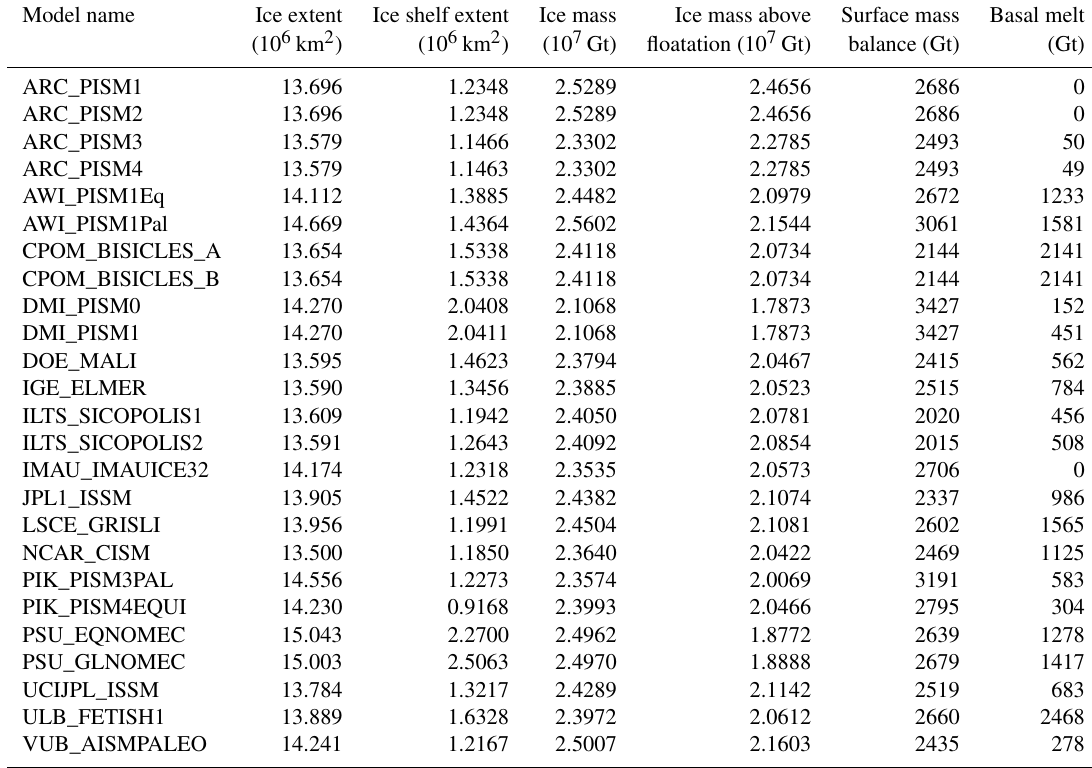
Table C1. Simulated Antarctic initial ice-covered extent, ice shelf extent, ice mass, ice mass above floatation, total SMB, and total basal